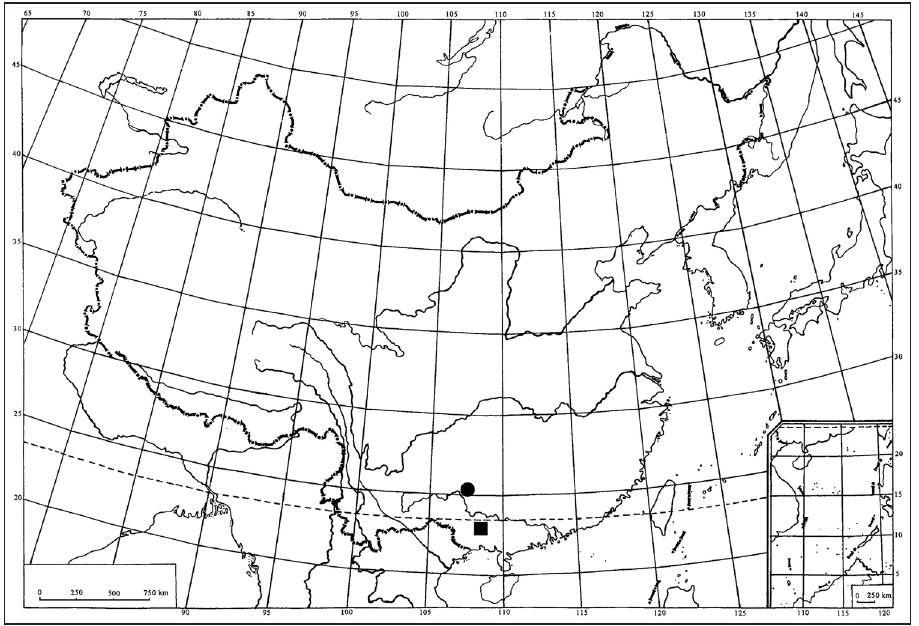
Figure 23. Geographic distribution of two new Abrus species in China: A. damingshanensis sp. n. ( ■ ); A. expansivus sp. n. ( ●